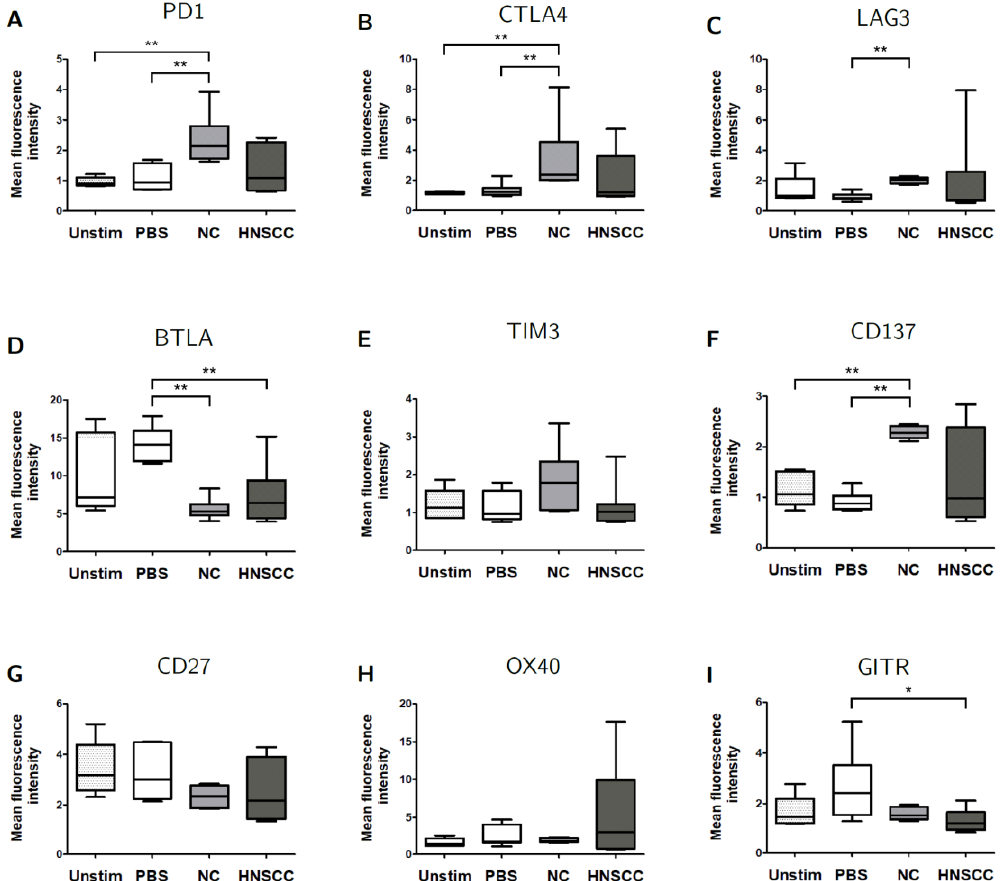
Figure 4. B cells were harvested after 2 days of co-culture with either NC or HNSCC exosomes or PBS and stained for FACS analysis. ( A ) The expression of PD-1 on B cells was increased after co-culture with NC exosomes. ( B ) The expression of CTLA4 on B cells was increased after co-culture with NC exosomes. ( C ) The expression of LAG3 on B cells was increased after co-culture with NC exosomes. ( D ) The expression of BTLA on B cells was reduced after co-culture with NC or HNSCC exosomes. ( E ) Expression of TIM3 on B cells. ( F ) The expression of CD137 on B cells was increased after co-culture with NC exosomes. ( G ) Expression of CD27 on B cells. ( H ) Expression of OX40 on B cells. ( I ) The expression of GITR on B cells was reduced after co-culture with HNSCC exosome. **: p < 0.01; *: p < 0.05, n = 8 (HNSCC), n = 6 (NC), n = 5 (Unstim). Unstim = Unstimulated B cells, NC = no cancer (exosomes from blood plasma of healthy volunteers), HNSCC, exosomes from blood plasma of HNSCC patients.